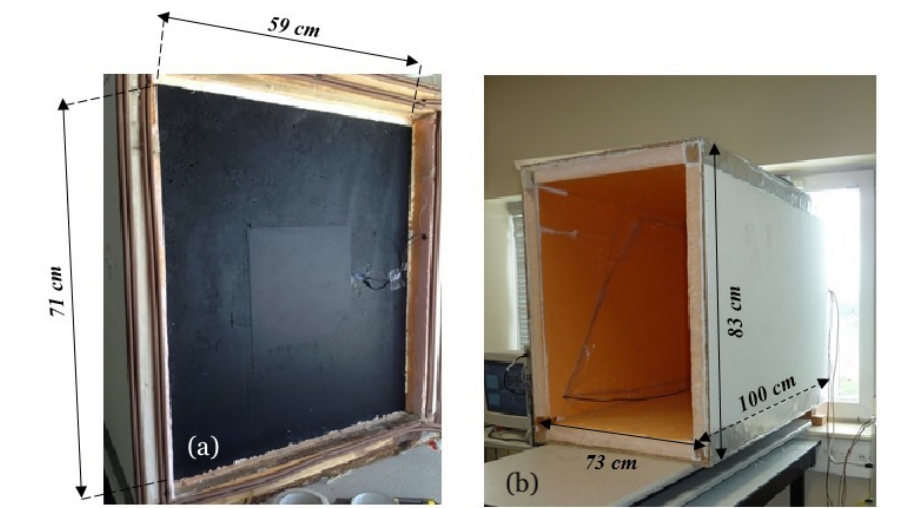
Figure 2. External view of the storage wall ( a ), and rear view of the experimental solar wall ( b ).